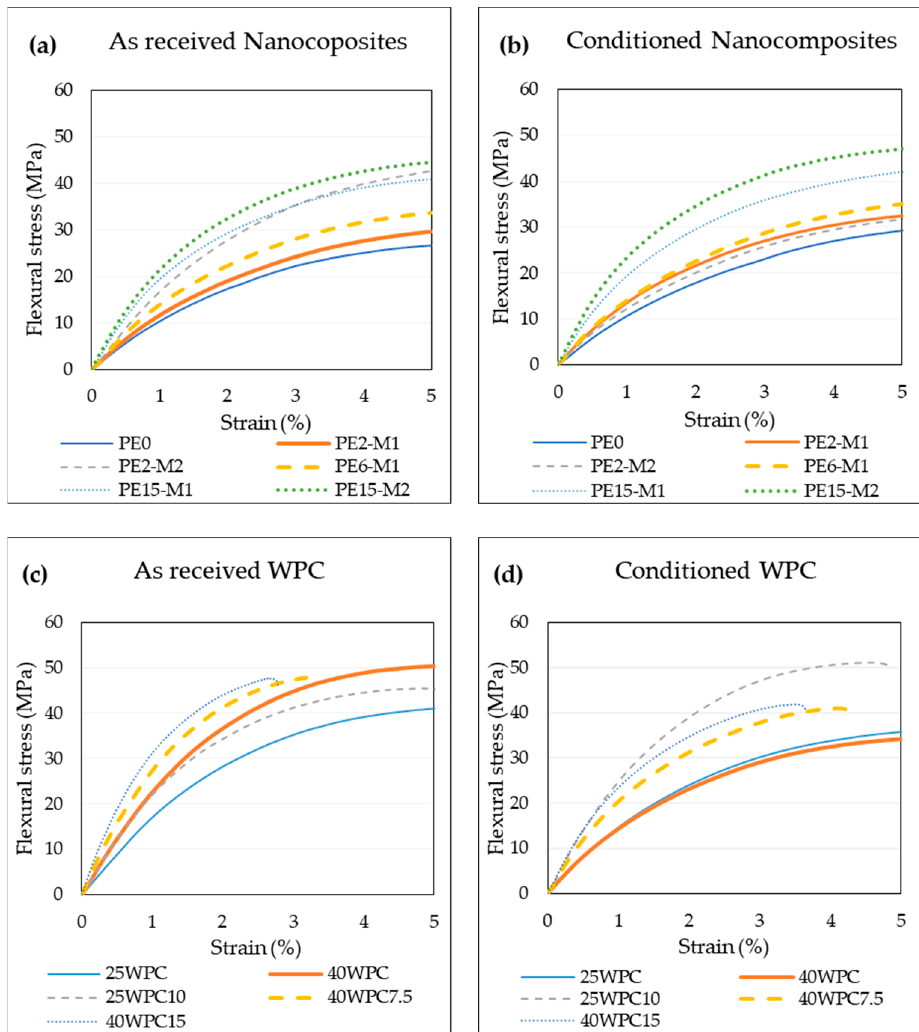
Figure 5. Flexural stress–strain curves of the as received and conditioned materials (at T = 40 °C and RH = 99%). Colored curves can be found in the online version of the article.